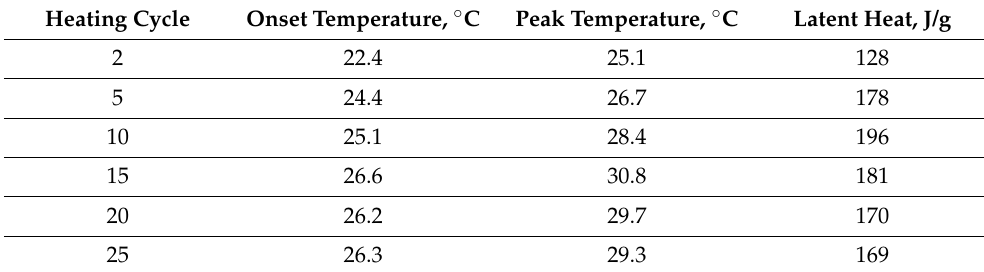
Table 1. Thermal cycle data for CaCl 2 · 6H 2 O based